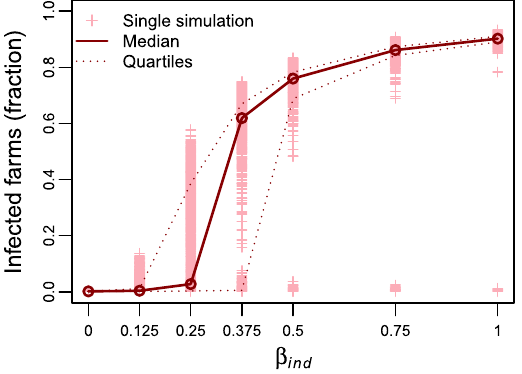
Figure 1. β ind sensitivity analysis. The distribution of the total epidemic size from 5,000 simulations for six values of β ind : 0, 0.125, 0.25, 0.375, 0.5, 0.75, and 1. Crosses represent the fraction of infected farms in each simulation, the thick line the median of the infected farms fraction for the epidemics with secondary cases, and the dotted lines the 25 th and 75 th quantiles.